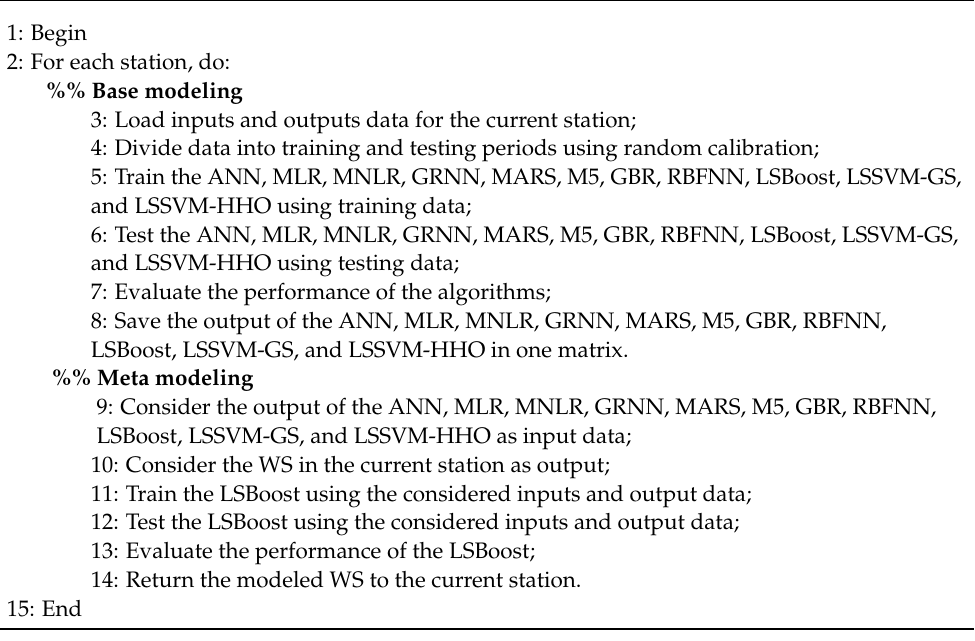
Algorithm 1. Pseudo-code of the proposed framework based on the SEML